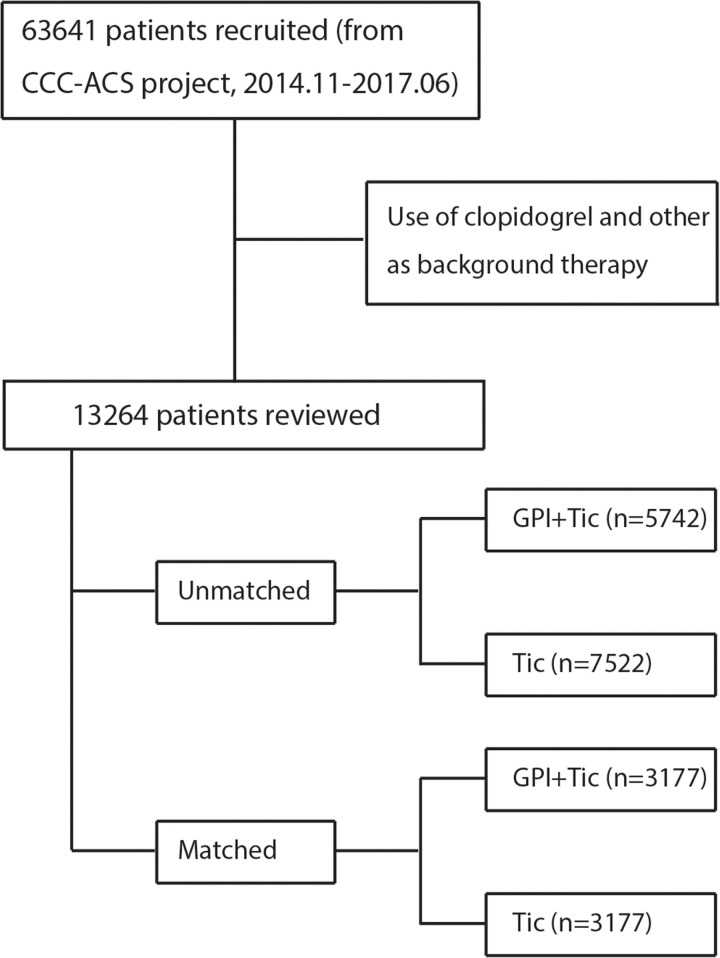
The study population.